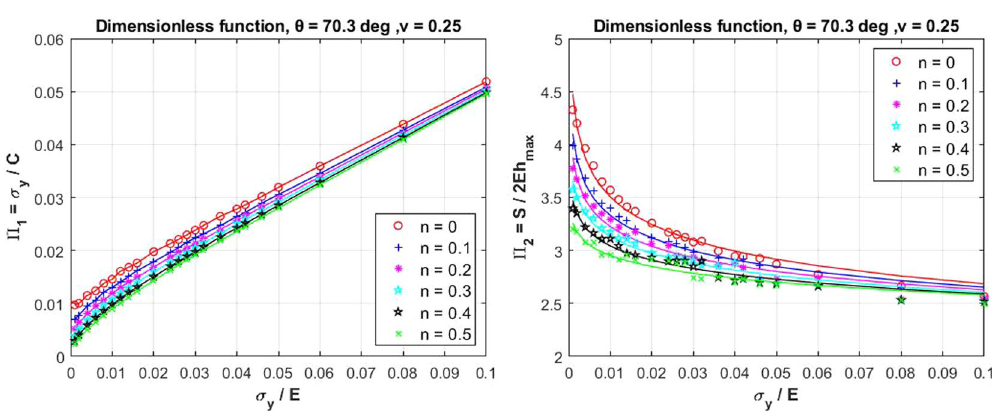
Figure 2. Dimensional functions Π 1 , and Π 2 for conventional